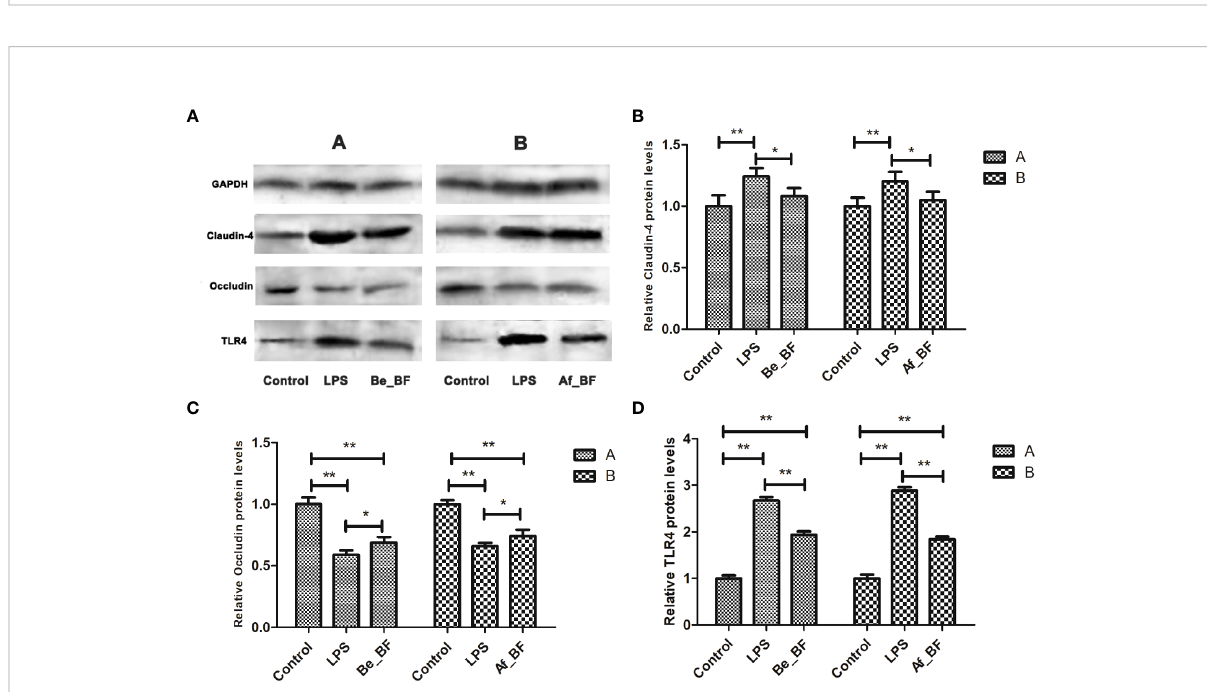
FIGURE 8 Relative expression of tight junction-related proteins and TLR4 at a proteomic level in the small intestine after B . fragilis treatment. (A) western blotting of TJ and TLR4 proteins; (B) relative Claudin-4 protein levels; (C) relative Occludin protein levels; (D) relative TLR4 protein levels; LPS, LPS-treated group; Be_BF, B . fragilis treatment before injection of LPS; Af_BF, B . fragilis treatment after injection of LPS; GAPDH was used as a reference protein; * p < 0.05; ** p <